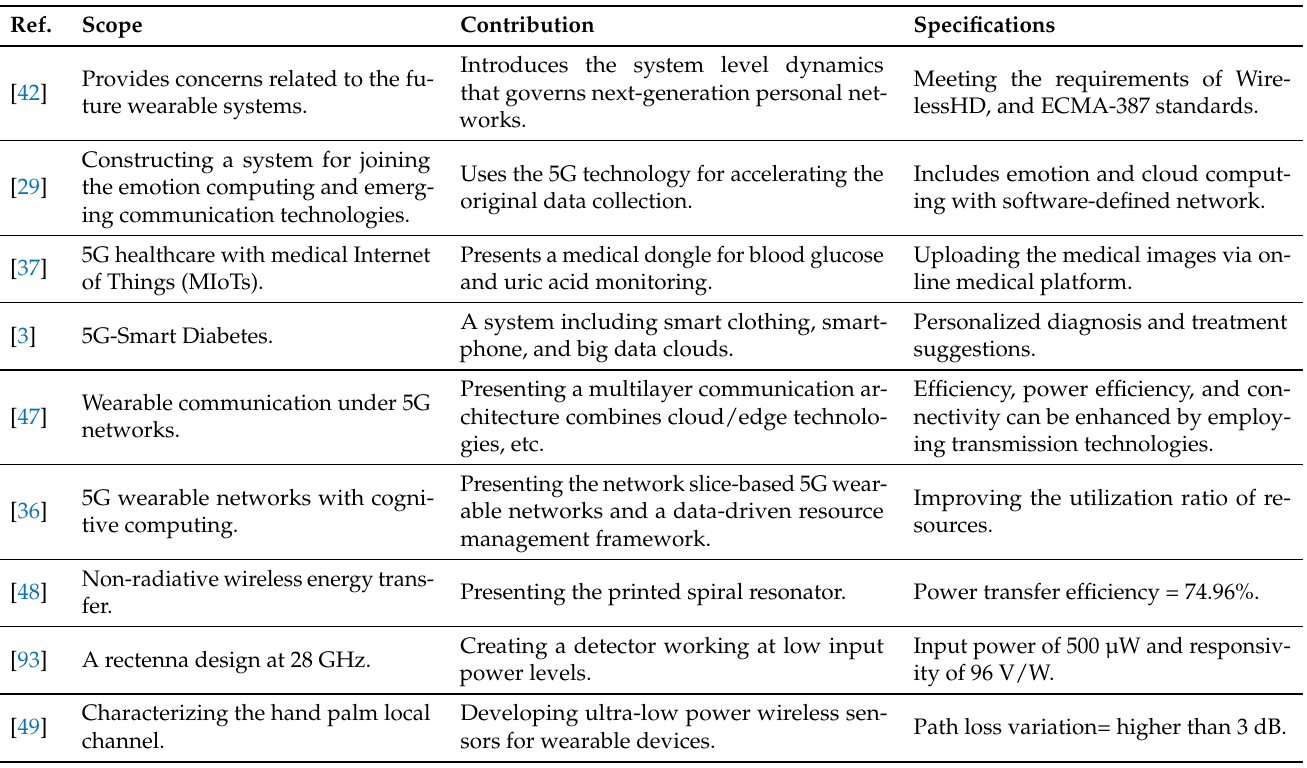
Table 1. Summary of some reported biomedical studies with the focuses and output specifications of each